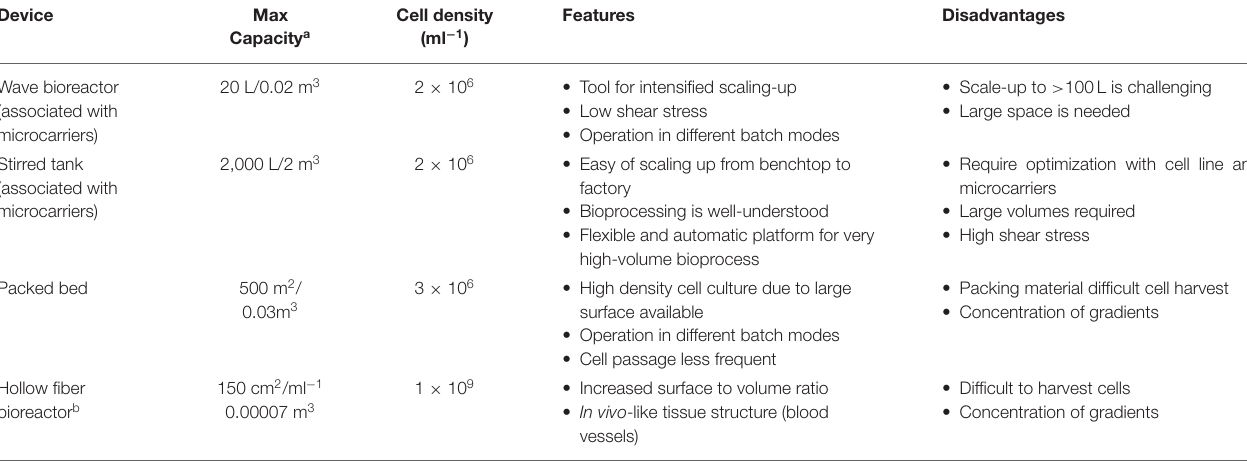
TABLE 2 | Table summarizing the advantages and limitations of the described large-scale systems.